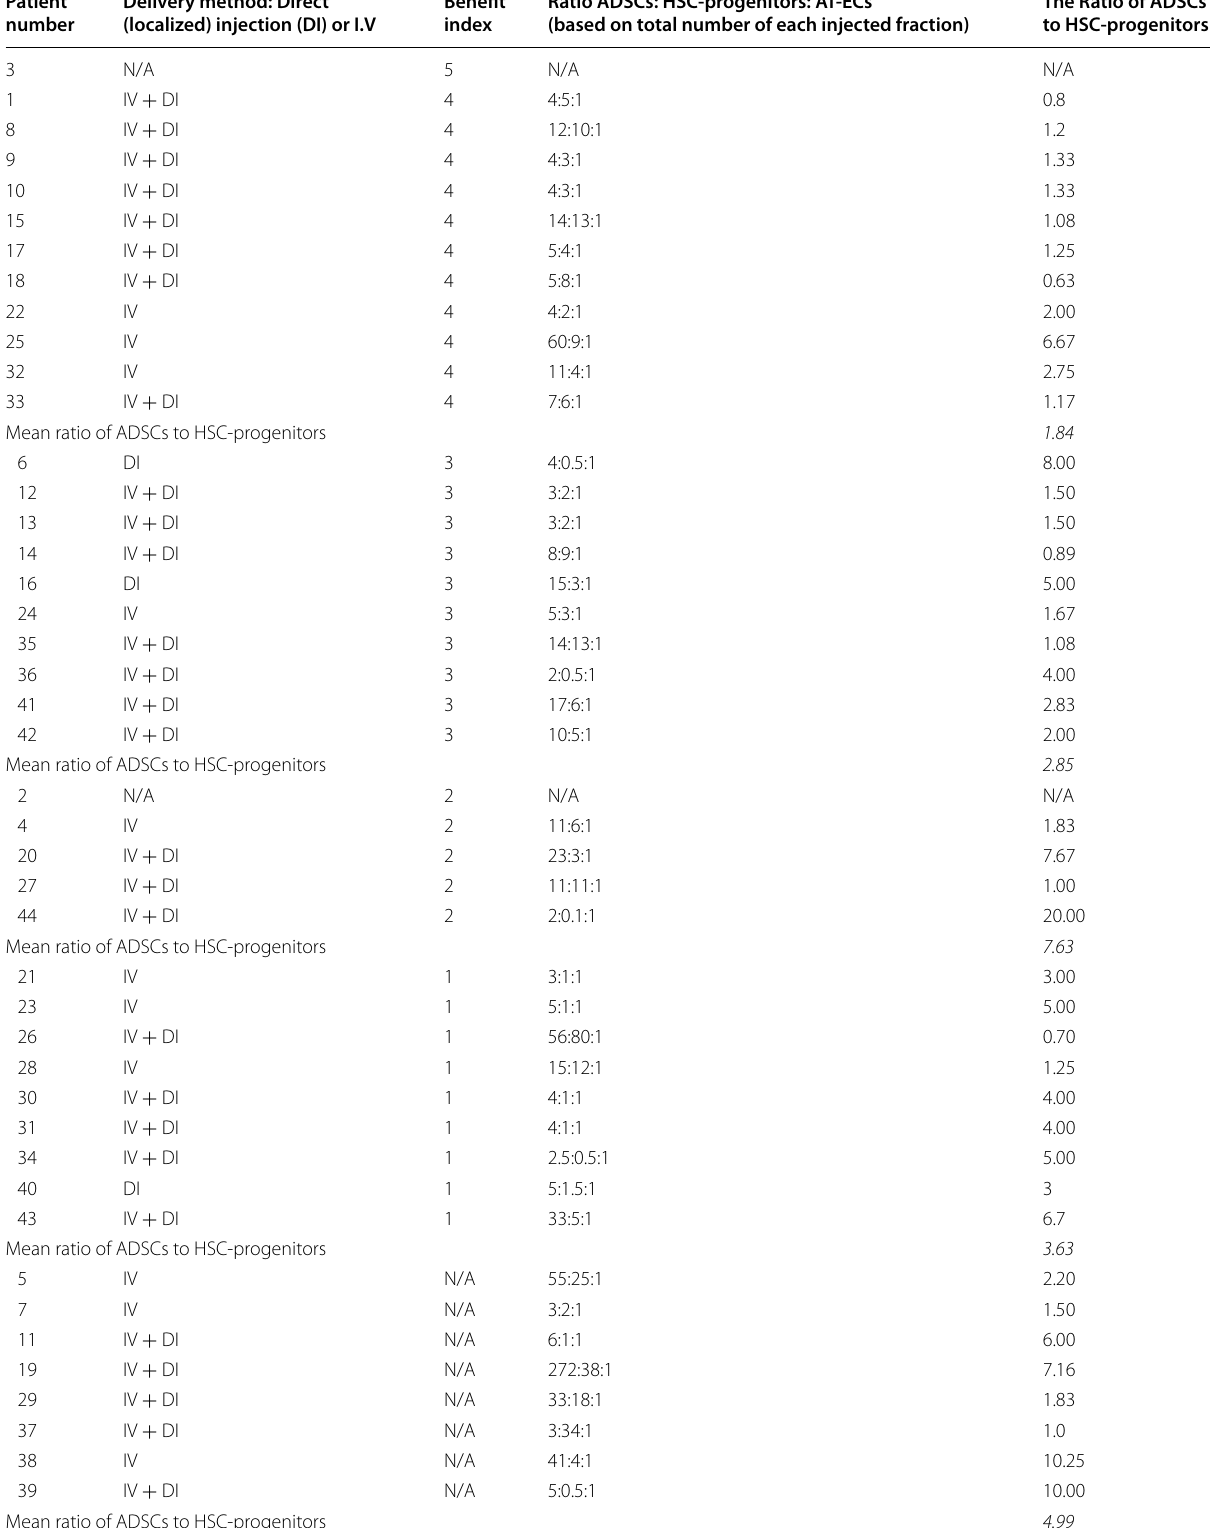
Table 4 The ratio of ADSCs, HSC-progenitors, and AT-ECs based on total number of each injected cell subset Patient